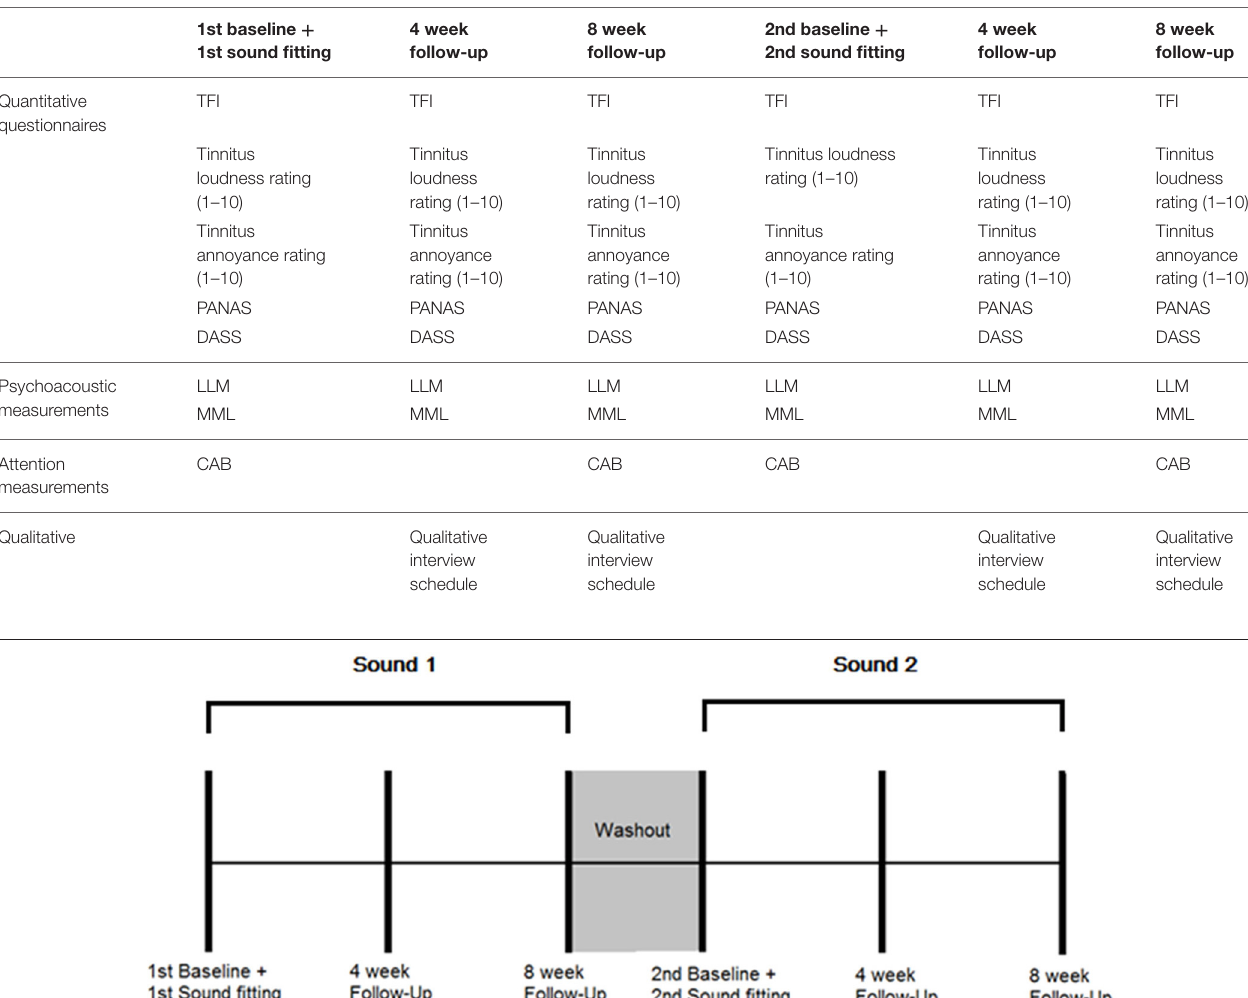
TABLE 1 | Outcome measurements taken at the different time points of the trial.